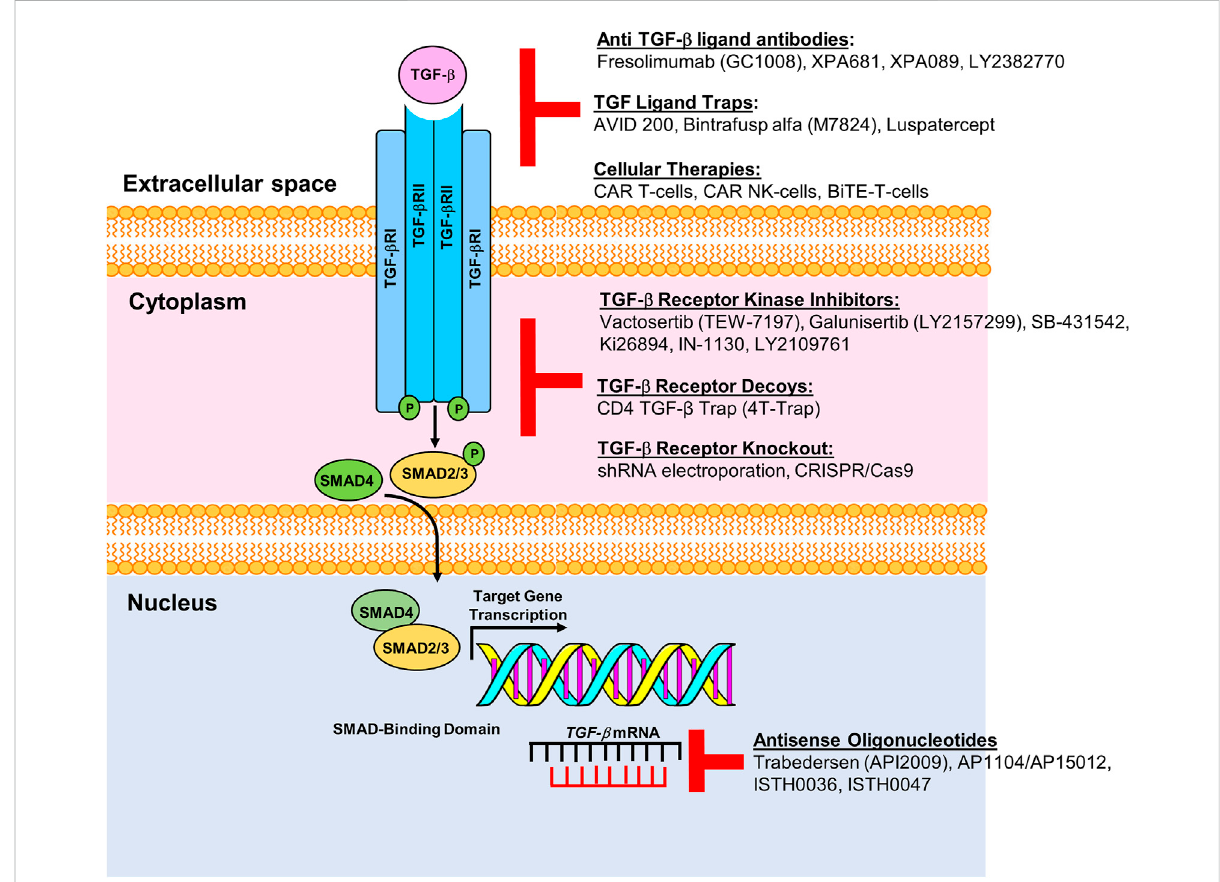
FIGURE 1 Pharmacologic and immunologic blockade of the TGF- β pathway. Schematic representation of multiple modalities developed or in development to target components of the TGF- β signaling pathway. Current roadblocks due to TGF- β mediated immune suppression can be overcome by targeting the TGF- β receptor with ligand antibodies, ligand traps or by inhibiting TGF- β receptors using speci fi c kinase inhibitors, receptor decoys or by knocking out the TGF receptor gene. Antisense oligonucleotides, e.g., AP11014 and AP15012, can silence or suppress TGF- β at the transcriptional level. Figure is adapted from Kim et al.,